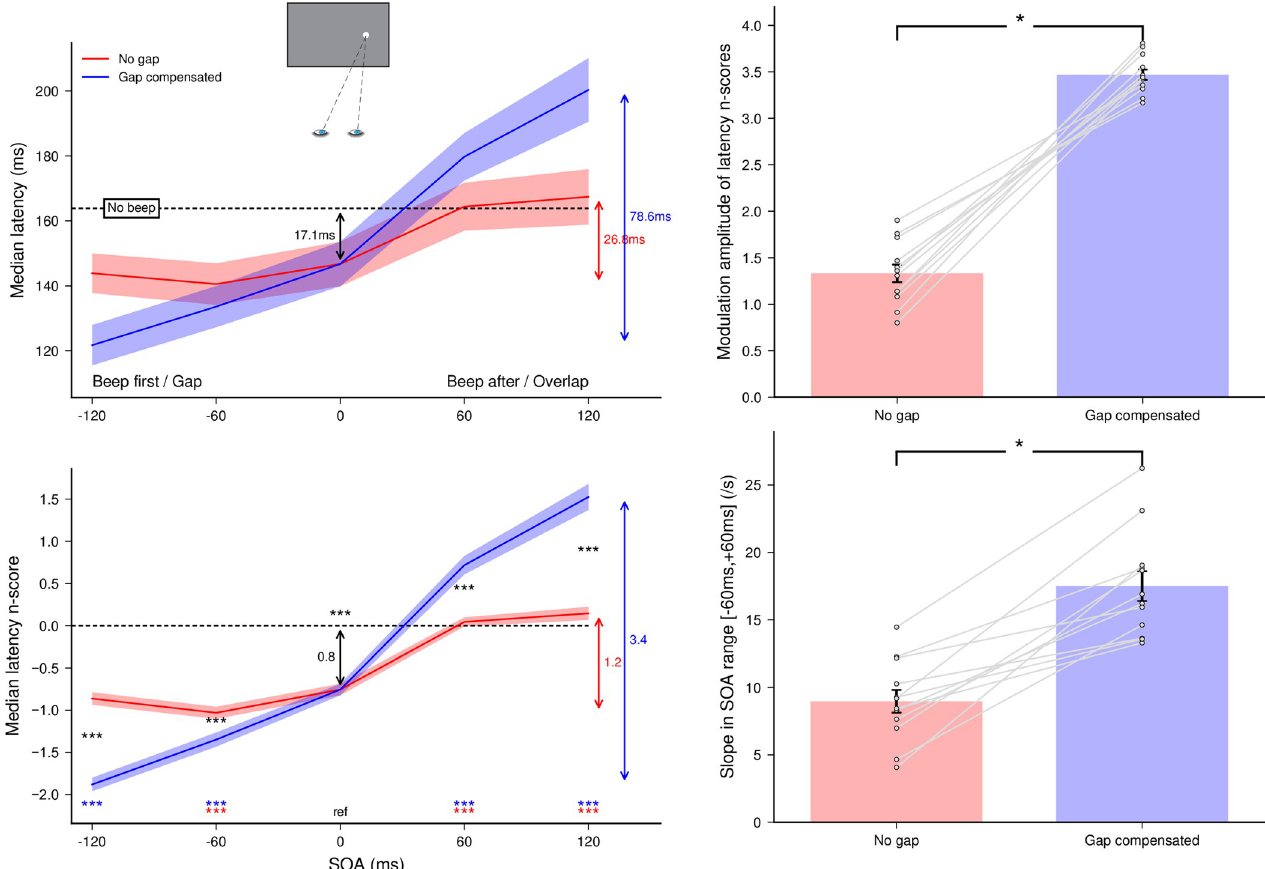
Fig 3. Experiment 1a. Effect of gap compensation on saccade latency. (Left panel) Median latencies averaged across participants for the No gap and Gap compensated conditions as a function of SOA (top) and their corresponding n scores (bottom). Dashed lines show the No beep baseline condition level. Statistics performed on the n scores included a single sample t-test to compare the 0-ms SOA reference condition with the No beep condition (black arrow), and for each gap factor separately, paired t-tests compared this reference with each SOA condition (colored stars for each SOA above the X-axis). Finally, paired t-tests compared No gap and Gap compensated conditions for each SOA (black stars between curves). Three stars indicate highly significant differences for the paired t-tests after Bonferroni correction (p < 0.00556). (Right panel) Modulation amplitude of latency median n scores (top) and slopes of the linear regressions within the range [ − 60 ms, +60 ms] (bottom) computed for each gap factor. Grey lines show individual results and error bars indicate inter-individual SEM. Comparisons were done using paired t-tests.